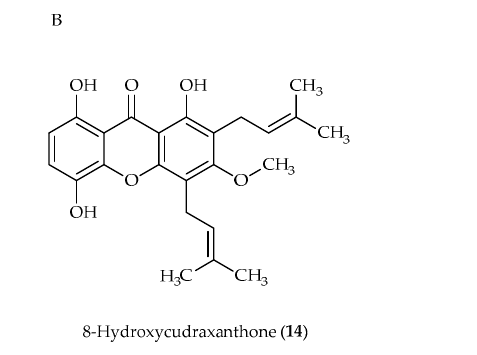
Figure 7. Chemical structures of Cudraxanthone derivatives.